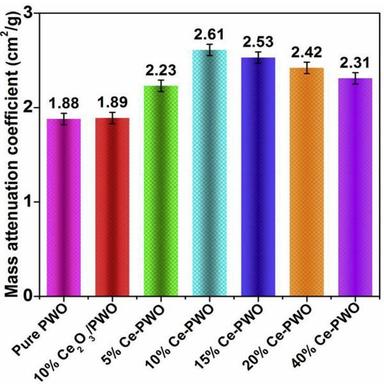
Gamma-ray shielding properties of the PbWO4 doped with Ce at different molar fractions.